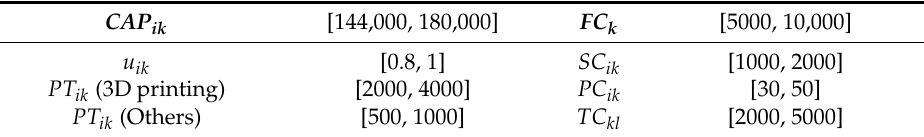
Table 3. Data used in the experiments.